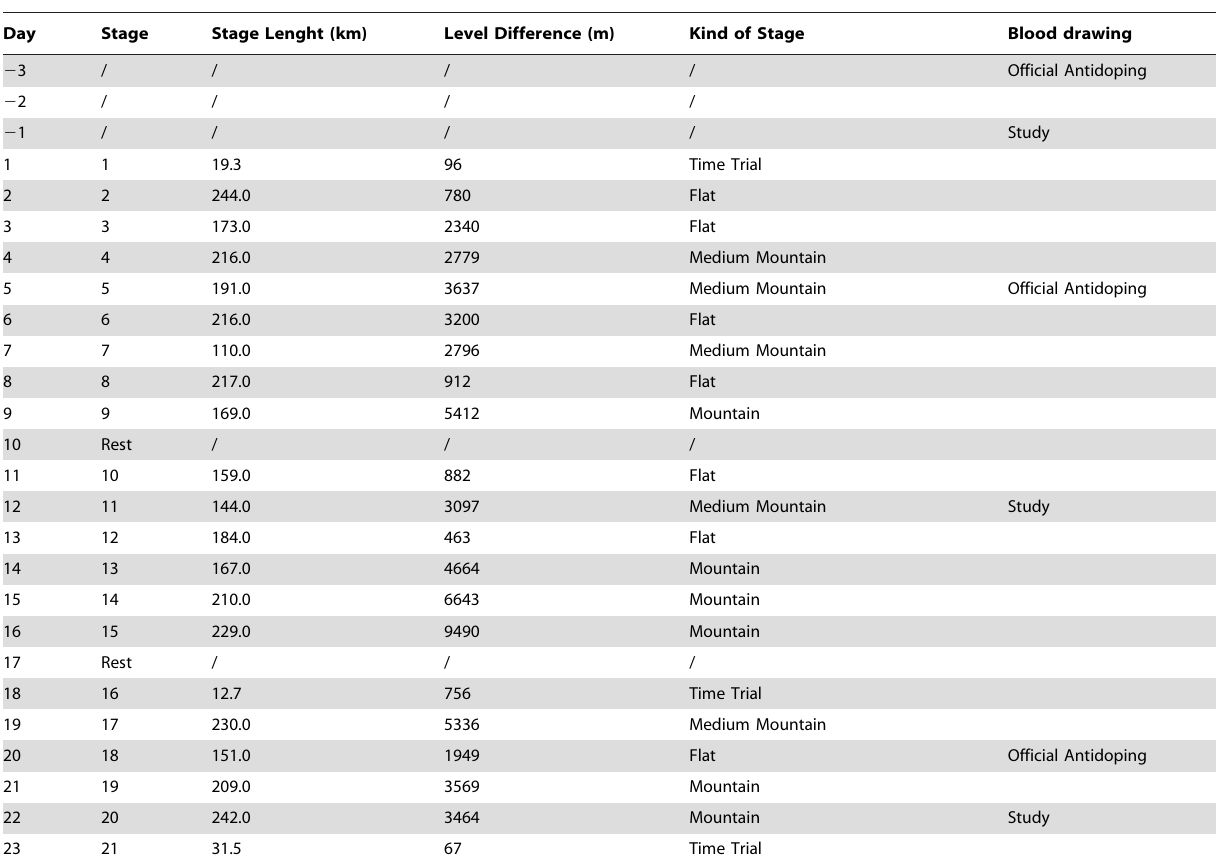
Table 1. Characteristics of the